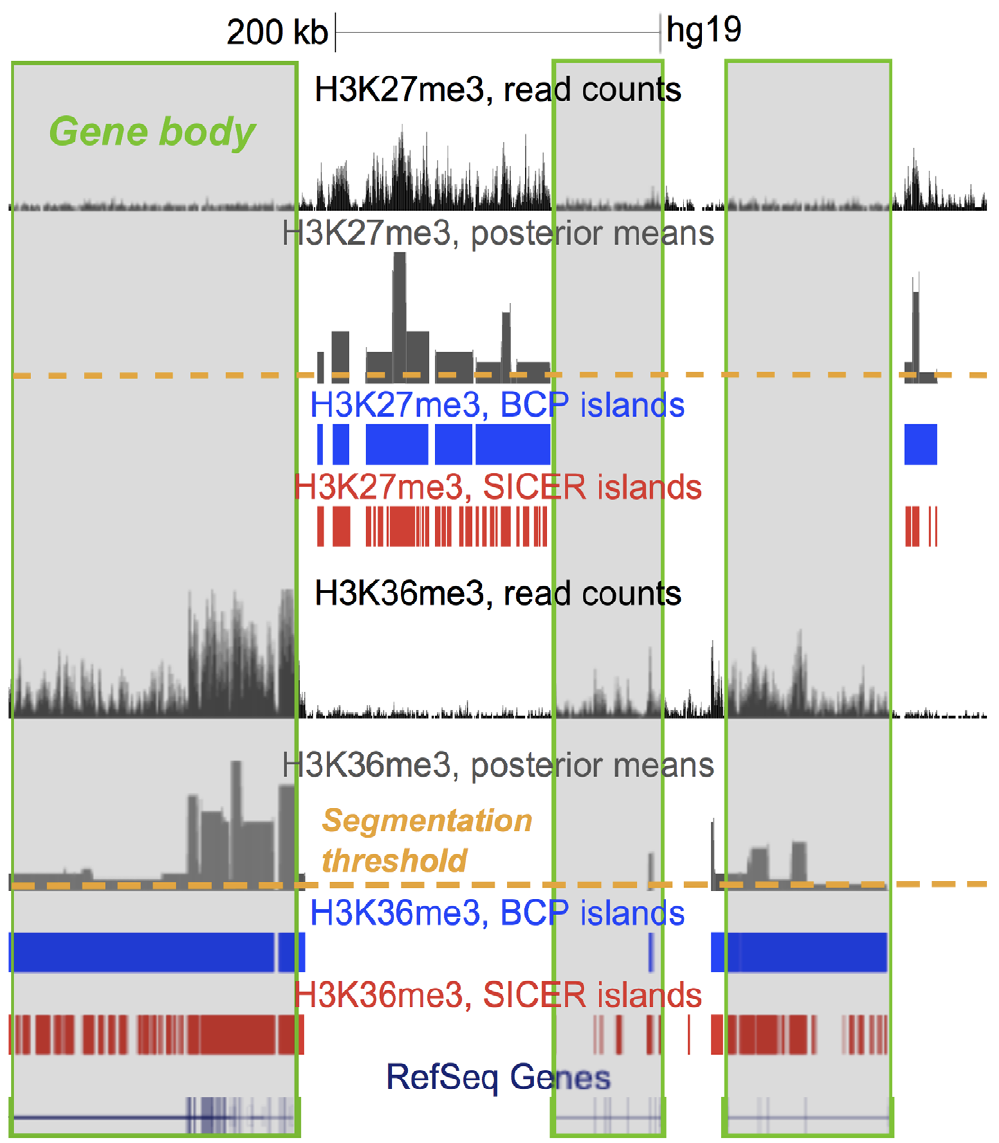
Figure 1. H3K27me3 and H3K36me3 diffuse histone marks. ChIP-seq was used to identify regions of enrichment based on read density profiles, visualized here in the UCSC genome browser (http://genome.ucsc.edu/). The enriched islands identified by BCP (blue) and SICER (red) are indicated. Additionally, posterior mean estimates used in BCP island detection are shown along with a line (orange) illustrating how thresholds are used to segment the signal. The correlation between H3K36me3 and gene bodies (outlined in green) and the mutually exclusivity of H3K27me3 and H3K36me3 were evident. The signal fluctuations caused by the highly variable read densities common to ChIP-seq data of diffuse marks is one of the notable difficulties for standard peak-calling algorithms, causing them to fragment the broader regions of enrichment into smaller, discontiguous peaks.